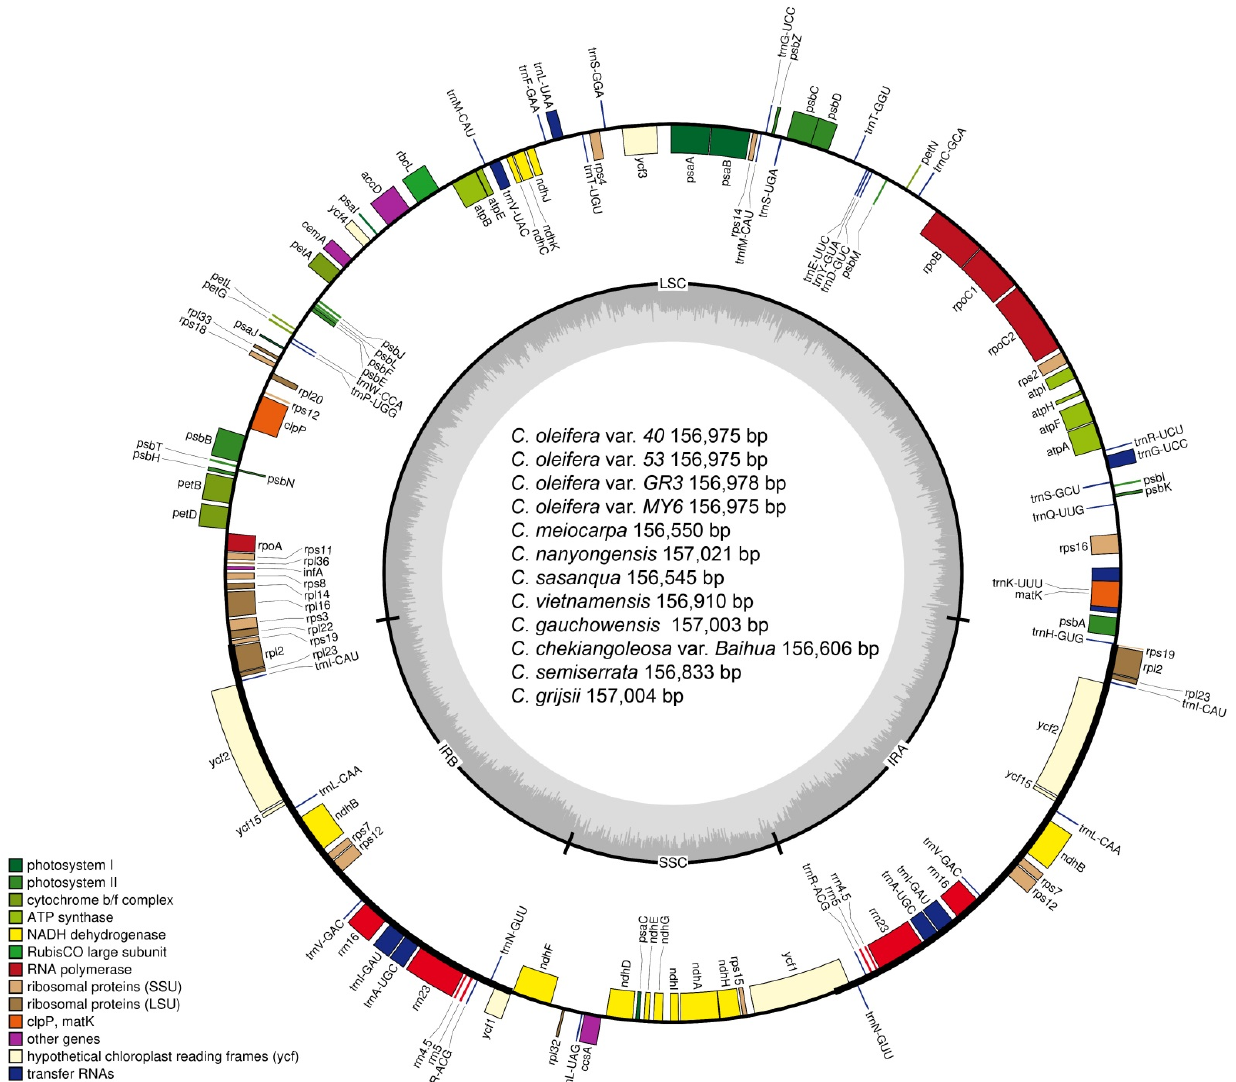
Figure 1. A gene map of the Camellia chloroplast genomes. The inner circle indicates the GC content, while the outer circle indicates the genome structure and gene arrangement. Genes shown outside the outer circle were transcribed clockwise and those shown inside were transcribed counterclockwise. Functional categories of genes are presented in the left margin.